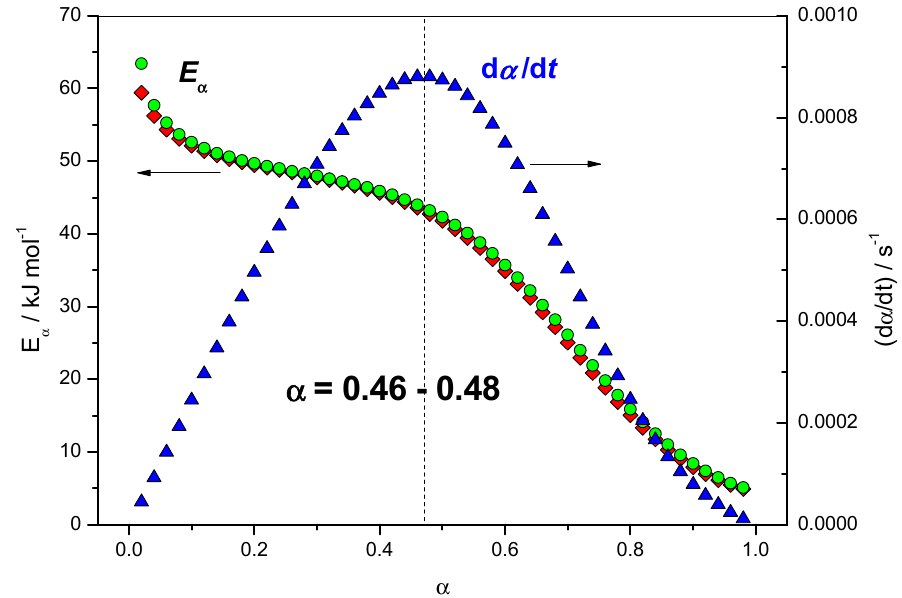
Figure 6. Dependence of the effective activation energy ( E α ) with the extent of conversion ( α ). Red lozenges: E α computed with FR method, green circles: E α computed with NLN method, blue triangles: (d α /d t ) computed as the product of [ A α f ( α )] by exp[ − E α /( RT α )] (Equation (6)).